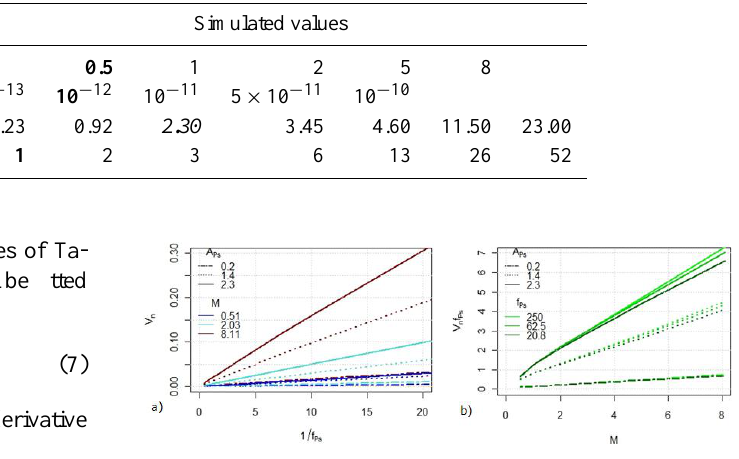
Figure 5: Fig. 4. (a) Linear relation between dimensionless recharge period 1 /f P and the normalised volume deviation V n for h P i = 1mm s day − 1 . (b) Multiplying f P and V n on the y-axis and relating this to s the mass flux ratio ( M ) shows a linear relation dependent on A P